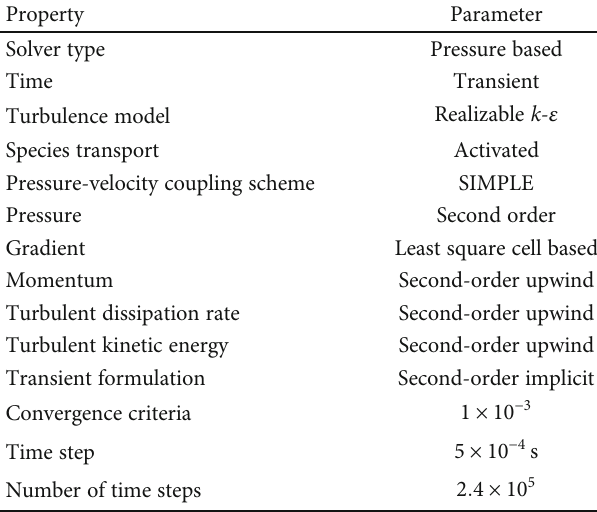
Table 1: Simulation